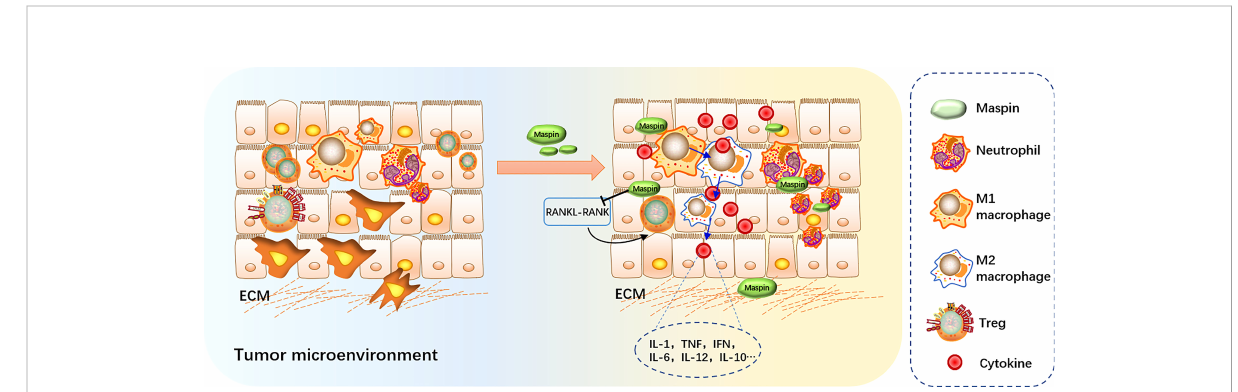
FIGURE 2 Maspin in regulating host immune surveillance. Maspin-expressing tumors induced neutrophil in fi ltration and macrophage M1 polarization, inhibiting tumor-in fi ltrating Tregs by activating the RANKL-RANK signaling pathway. Maspin contributes to remodeling the tumor microenvironment by regulating the macrophage secretion of in fl ammatory